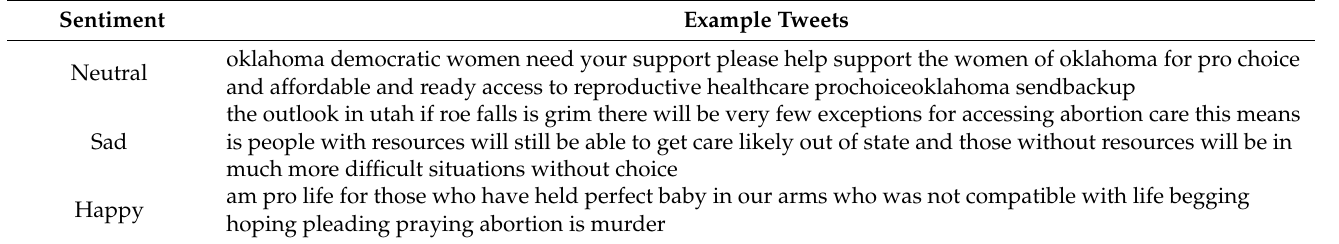
Table A3. Example tweets across sentiment categories.